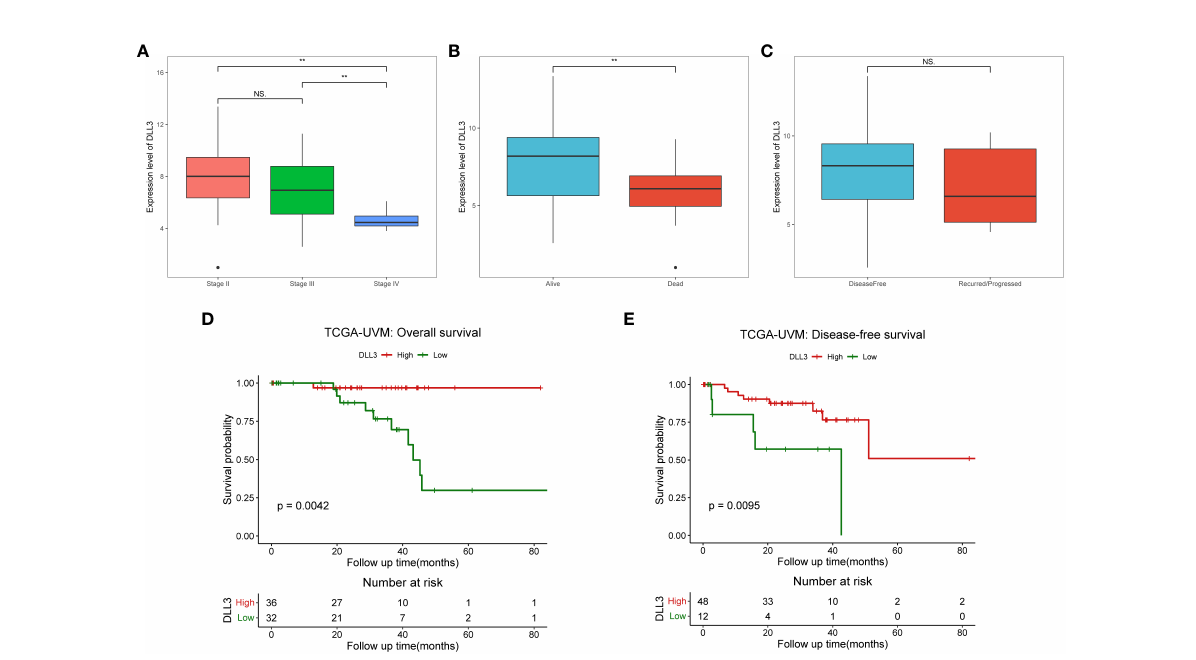
FIGURE 3 UM patients with high DLL3 expression were more likely to have favorable clinical outcomes. (A – C) The relationships between DLL3 expression and clinical features, including pathological stage (A) , living status (B) , and disease-free status (C) . (D, E) Kaplan-Meier curves demonstrated that high DLL3 expression signi fi cantly prolonged the overall survival (D) and disease-free survival (E) of UM patients. NS, no statistical signi fi cance, ** P <